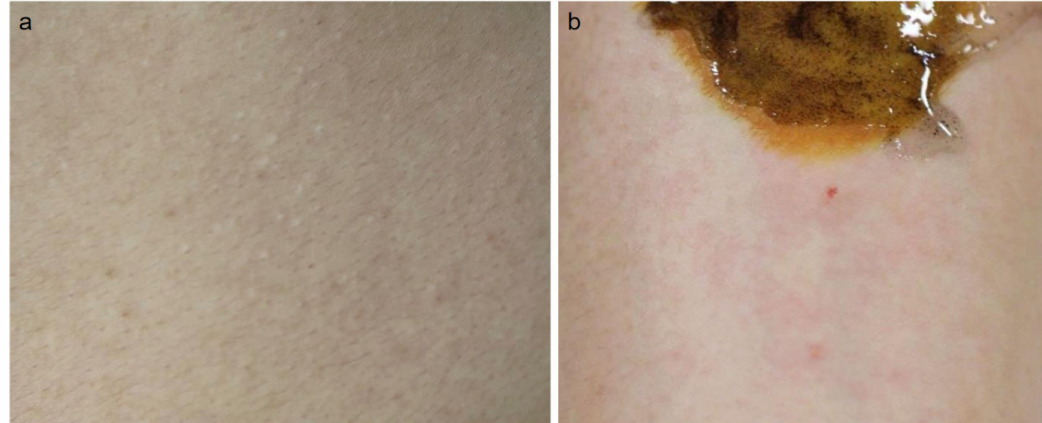
Figure 1. Clinical appearance of cholinergic urticaria (CholU) and acetylcholine (Ach) injection test. Pinpoint wheal of CholU ( a ). Satellite wheal around intradermal injection of Ach ( b